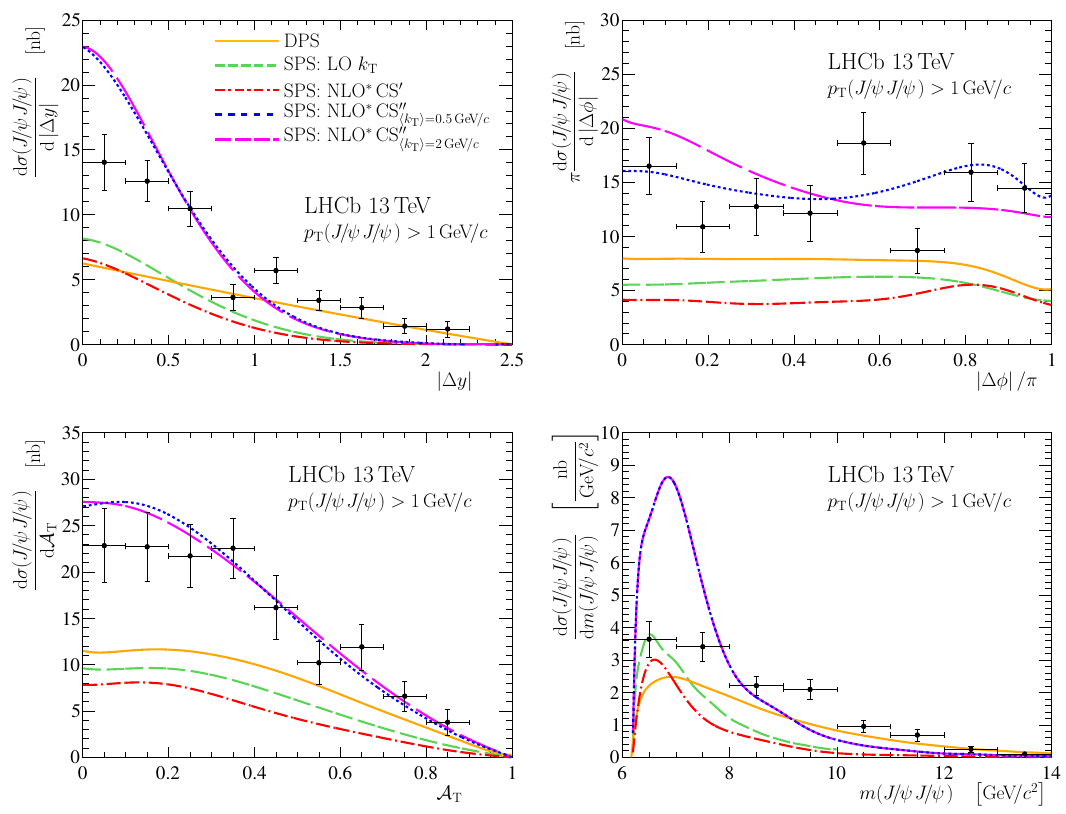
Figure 6. Comparisons between measurements and theoretical predictions with p T ( J= J= ) > 1 GeV =c for the di(cid:11)erential cross-sections as functions of (top left) tom left) and (bottom right) m ( J= J= ). The (black) points with error bars represent the A T